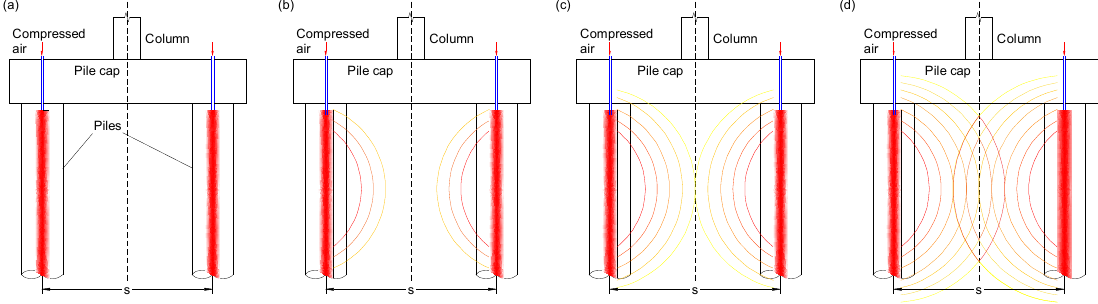
Figure 2. Thermal transfer in group piles for energy storage: ( a ) initial heating; ( b ) heat transferring; ( c ) heat reaching the center of piles; ( d ) heat penetrating to adjacent piles.